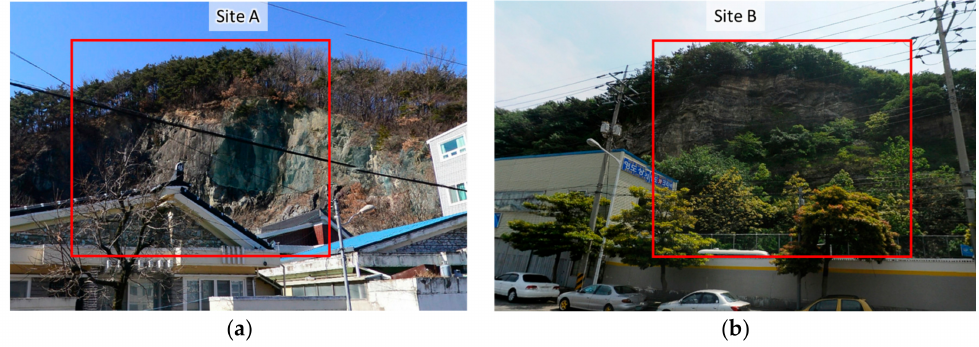
Figure 2. Lateral view of the study areas from the ground (street view of NAVER); ( a ) site A; ( b ) site